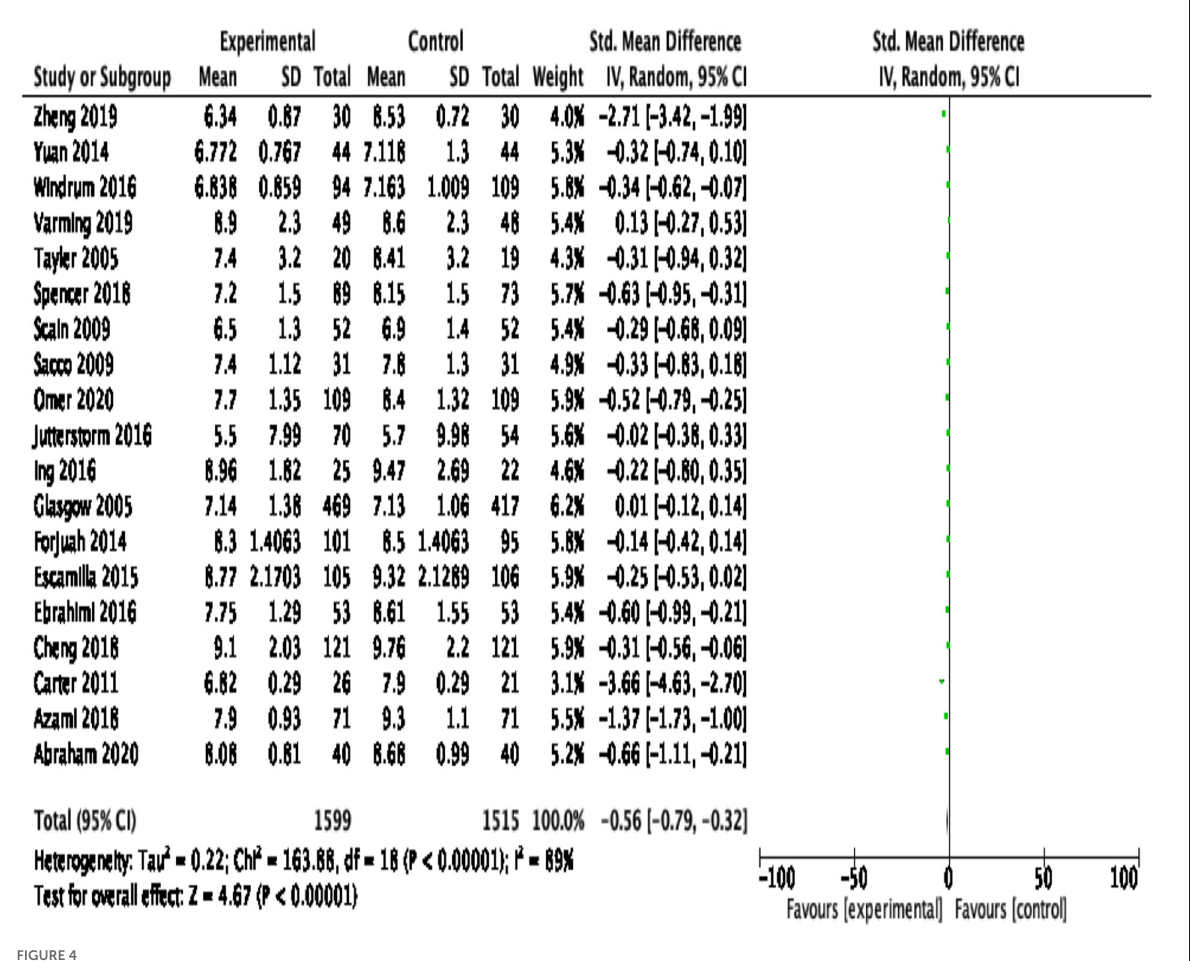
FIGURE4 Forest plot of pooled effect size of